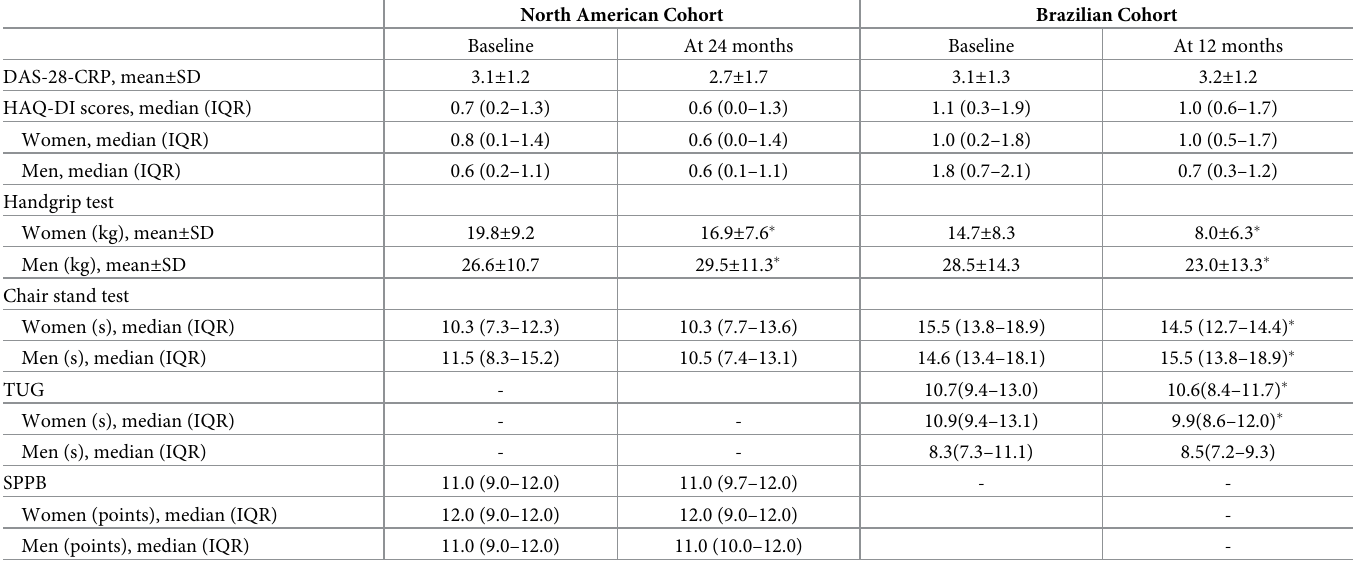
Table 4. Changes over time in self-reported physical function and clinical characteristics, muscle strength, and physical performance over time in the North Ameri- can and Brazilian cohorts.